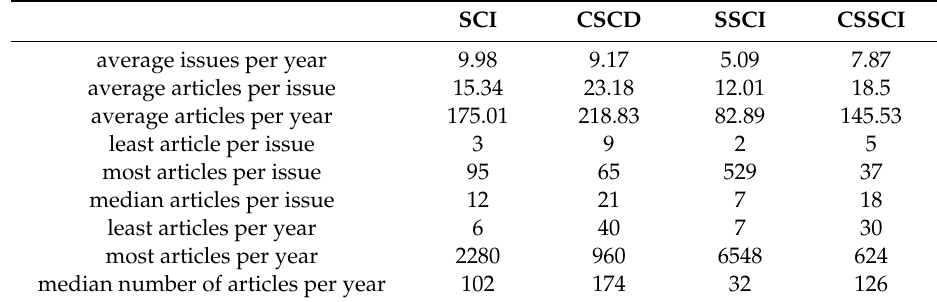
Table 3. Sample data from SCI, SSCI, Chinese Science Citation Database (CSCD), and Chinese Social Sciences Citation Index (CSSCI).